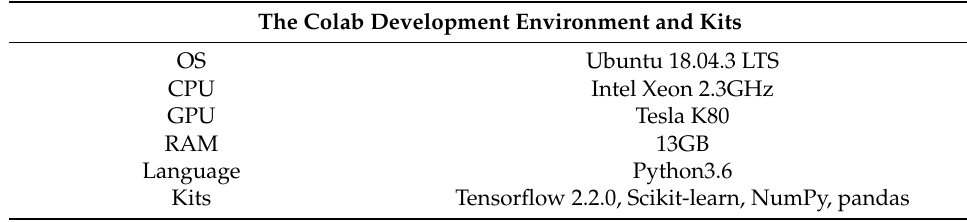
Table 3. The Colab development environment and kits.